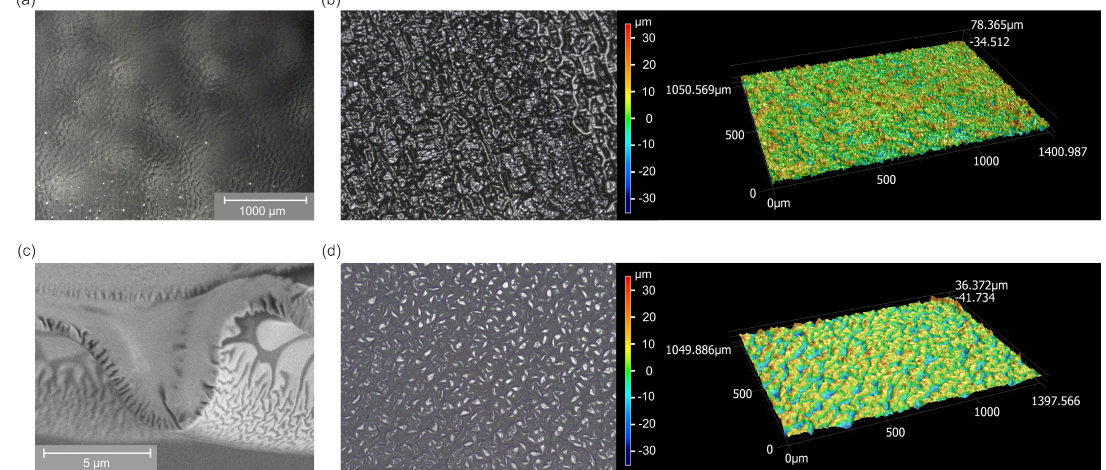
Figure 5. ( a ) Optical and ( b ) CLS microscopy images of a PEG substrate coated with a C 2 H 4 plasma and drained for 60min (both without PDMS backing, not yet lifted off the Petri dish). ( c ) Scanning electron and ( d ) CLS microscopy images of an Ar-C 2 H 4 -Ar sample (both with PDMS backing, lifted off the Petri